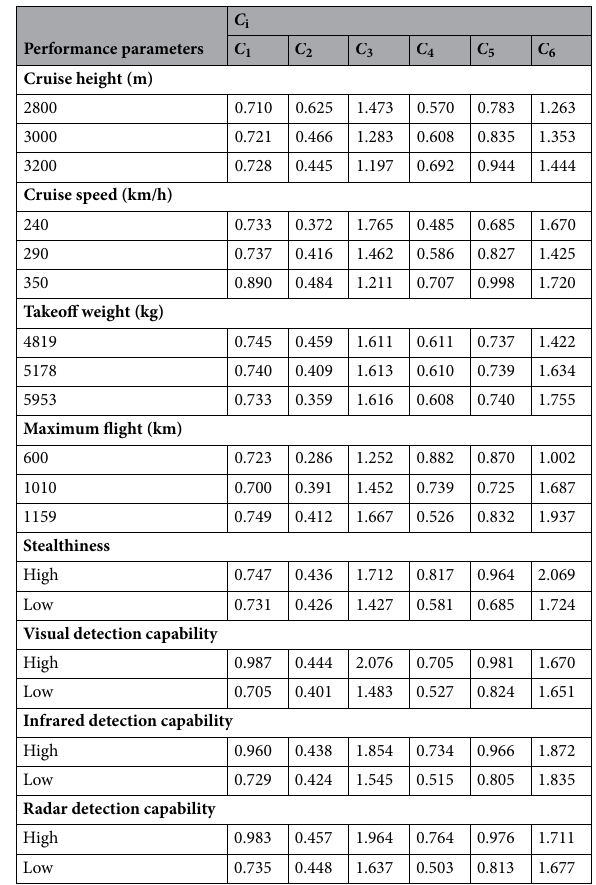
Table 12. Value of sub-capabilities C 1 ∼ C 6 of SARH with different performance parameters.